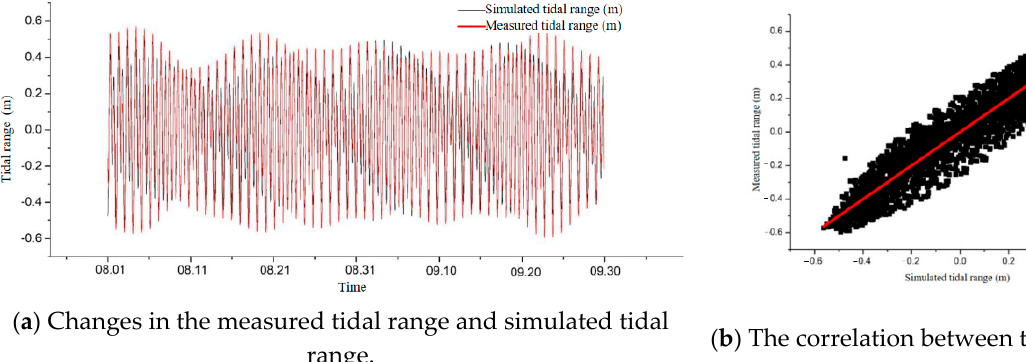
Figure 4. Changes in ( a ) and correlation between ( b ) the measured tidal range and simulated tidal range over time at 119.16° E, 37.19° N (Pearson’s r = 0.94).